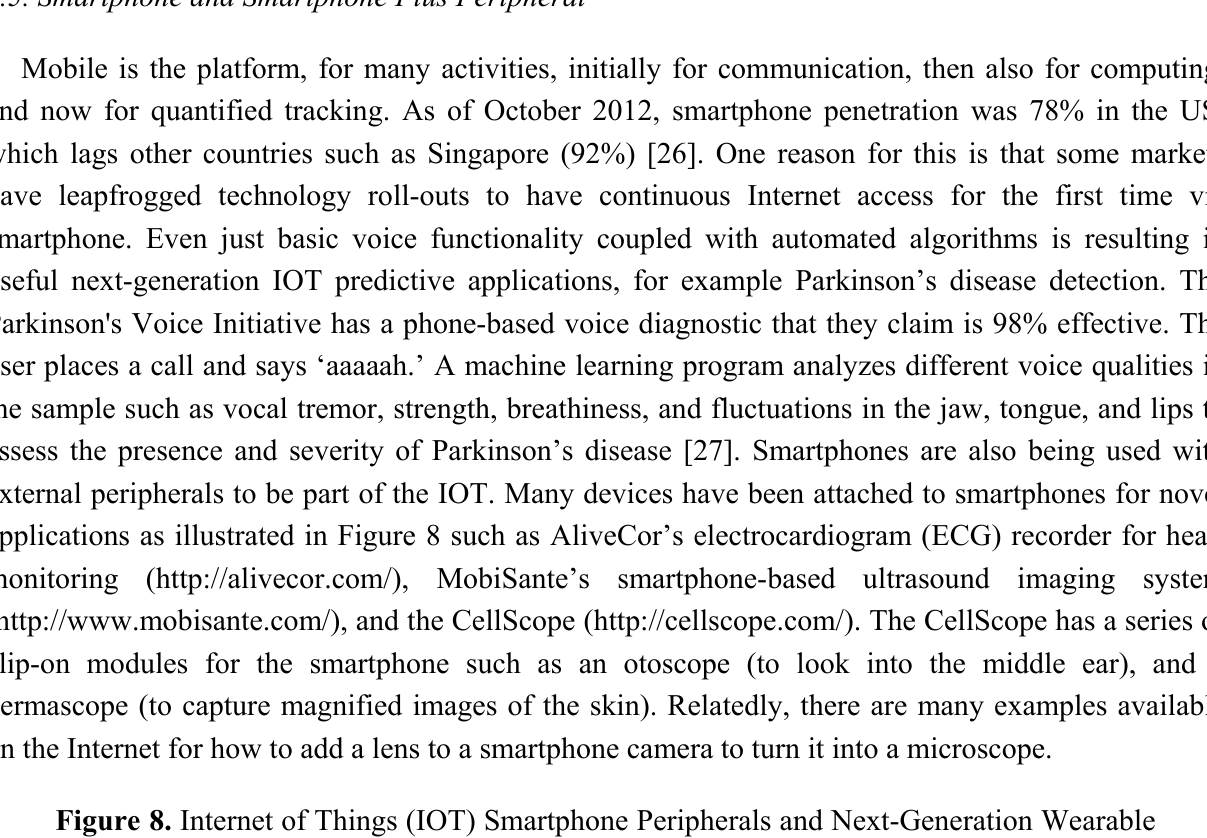
Figure 8. Internet of Things (IOT) Smartphone Peripherals and Next-Generation Wearable Computing: Consumer ECG, Mobile Ultrasound, CellScope, and Google’s Project Glass (per Antonio